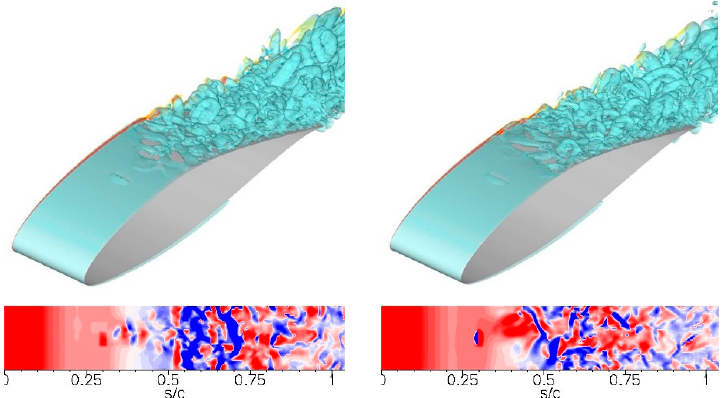
Figure 28. Re = 64,200 and α = 8.64 degrees: ( Top ) Isosurfaces of Q = 1 and isocontours of spanwise vorticity ( − 100 < ω z < 100). ( Bottom ) Suction surface skin friction ( − 0.01 < c f < 0.01). Pulsed VGJs with B = 1 ( left ) and B = 4 ( right ). (Reprinted from [31]).